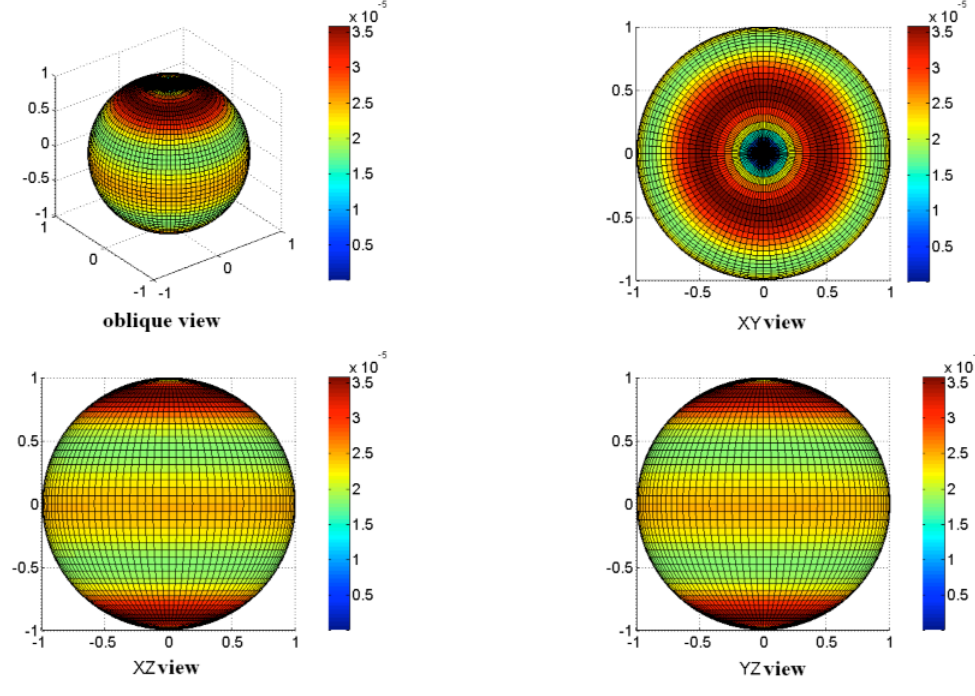
Figure 10. The distribution of on the sphere surface.